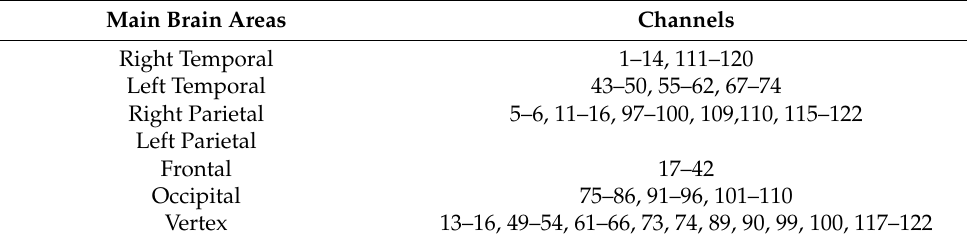
Table 1. Brain areas and the relative channels in each brain area. Main Brain